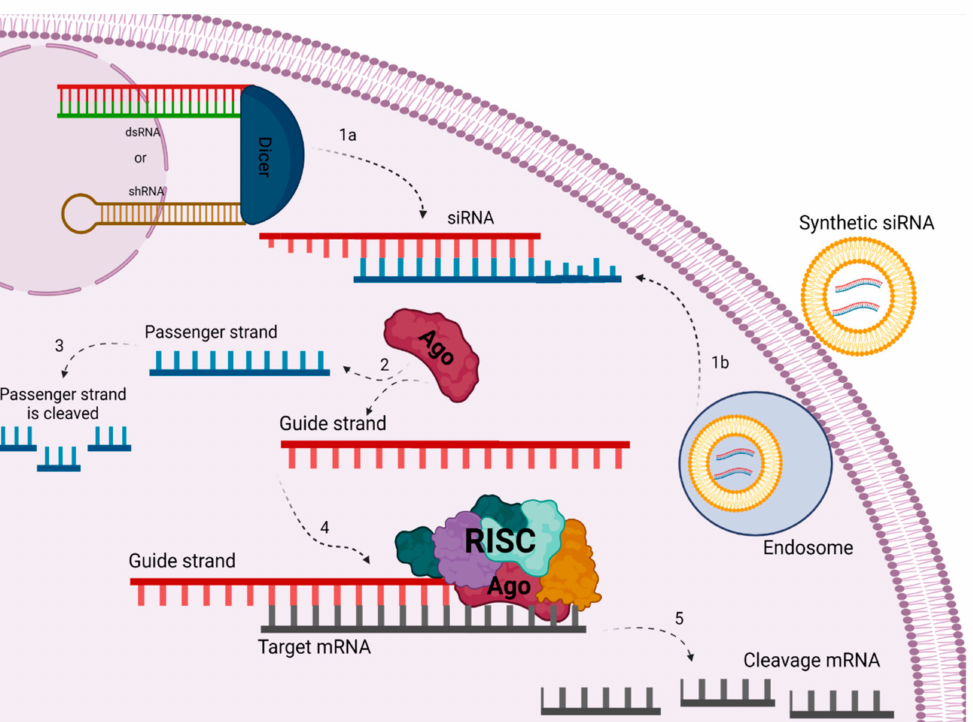
Figure 1. Gene silencing mechanism through siRNA in eukaryotic cells by different pathways: Through the endogenous pathway, long precursors, i.e., dsRNA or shRNA, are cleaved by the enzyme DICER into mature siRNA (1a). Via the exogenous pathway, the synthetic siRNA will enter a vesicle through the endosome and will be released into the cytoplasm (1b). Strand separation is done by the AGO protein (2), where the passenger strand will be cleaved (3) and the guide strand will be selected by the RISC complex to follow as a template for alignment with the mRNA (4). This will then be cleaved, thereby silencing the target gene (5). Created with